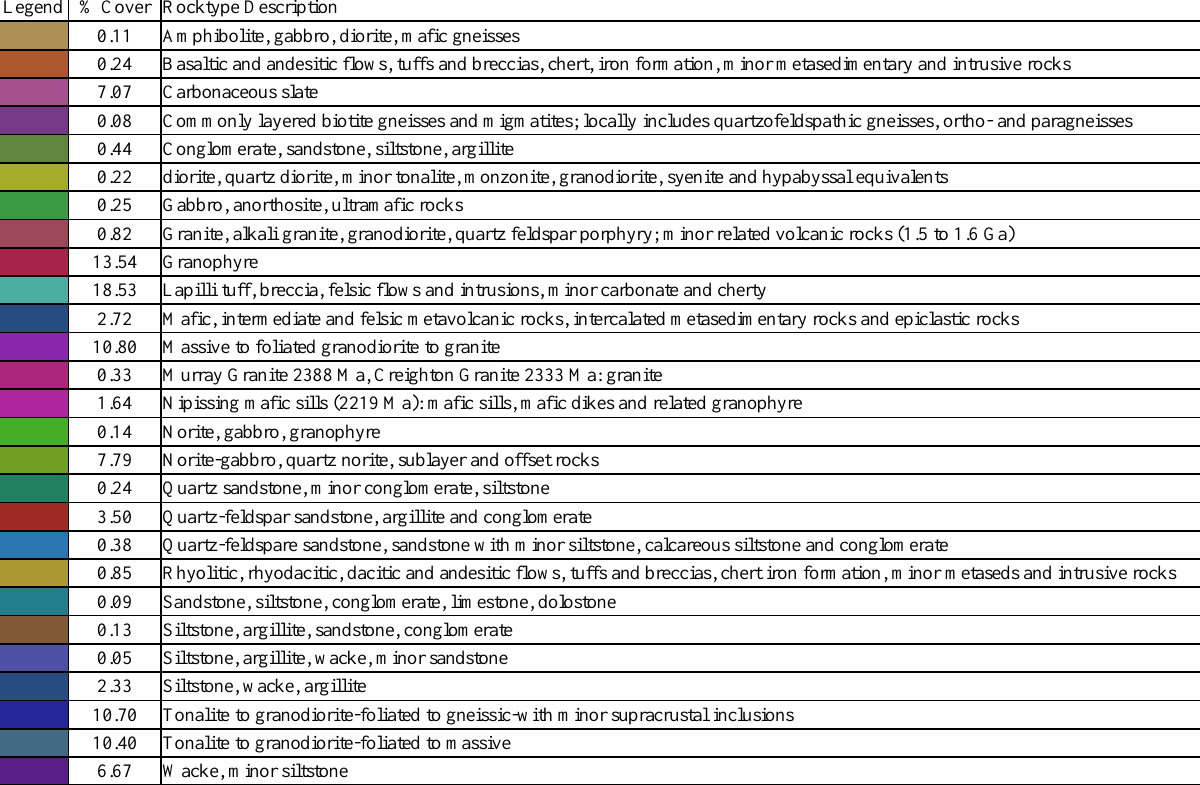
Table 3. Legend and rock type descriptions for Figure 2. Includes % of how much of the study area each rock type covers. Adapted from Ontario Geological Survey (2011).